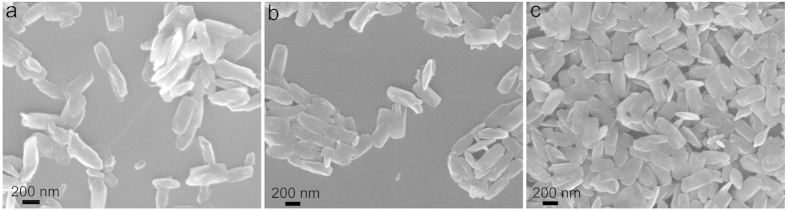
SEM images of (a) TiO2−x, (b) T300, and (c) T700.